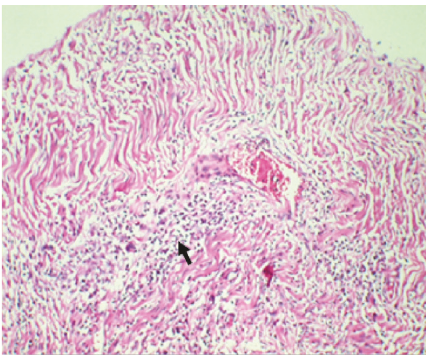
Figure 2: Dura (haematoxylin and Eosin) . Arrow : multinucleated giant cells associated with the small caliber vessel wall. Arrow : severe mononuclear